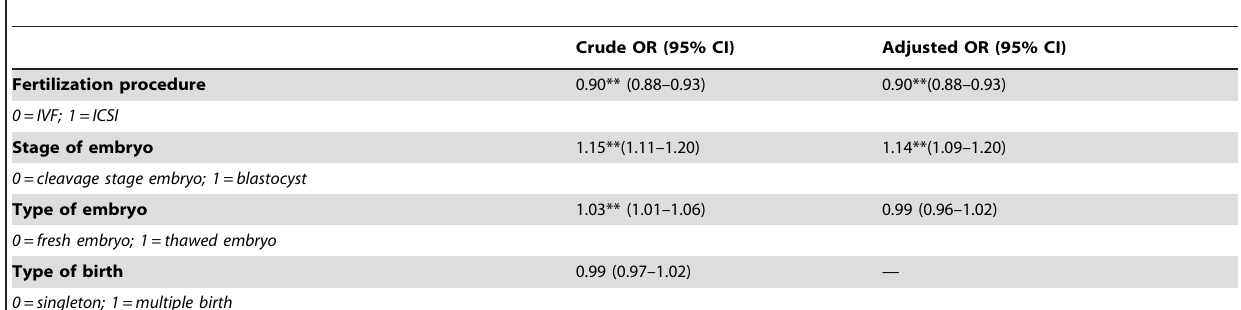
Table 2. Factors affecting SSR in ART babies by logistic regression